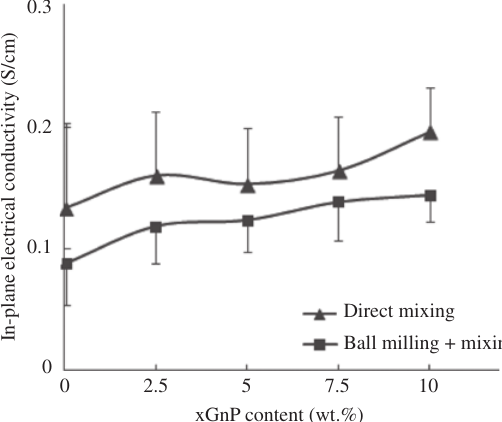
Figure 2: The effect of the xGnP on the in-plane electrical conduc- tivities of the PP/SG/xGnP composites.